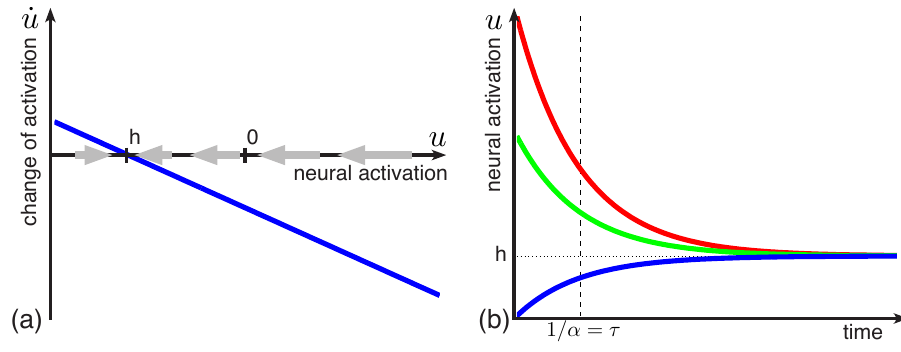
Figure 5: Dynamics of a single neural activation variable (Equation 7). Panel (a) shows the phase plot (blue), the grey arrows sketch the vec- tor field over u . Note how the length of the arrows corresponds to the value of the plotted function at that point; both vanish at the resting level h . Panel (b) shows three example trajectories relaxing to the resting level h from different initial values. The time interval τ after which all trajectories have reduced the initial distance to the attractor h by 36.8% is marked by a dashed vertical line.